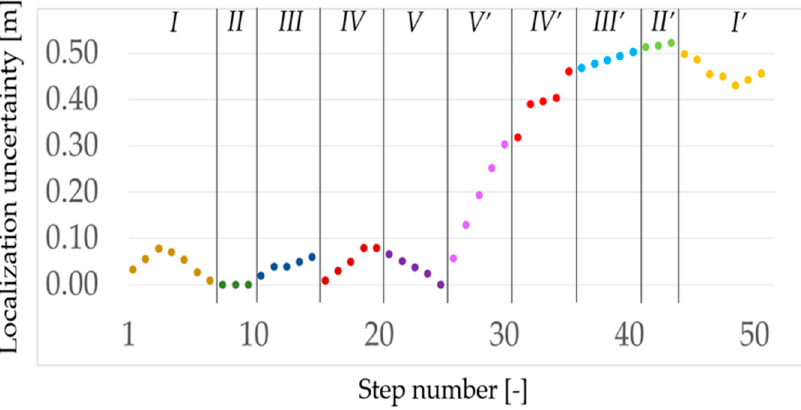
Figure 7. Test path for validation of PDR indoor localization.